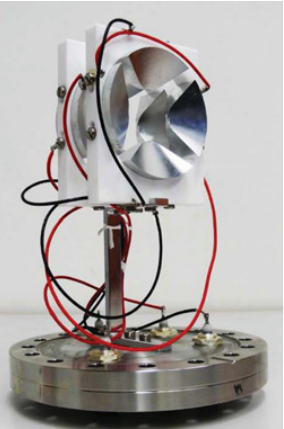
Figure 12. Electric quadrupole doublet.